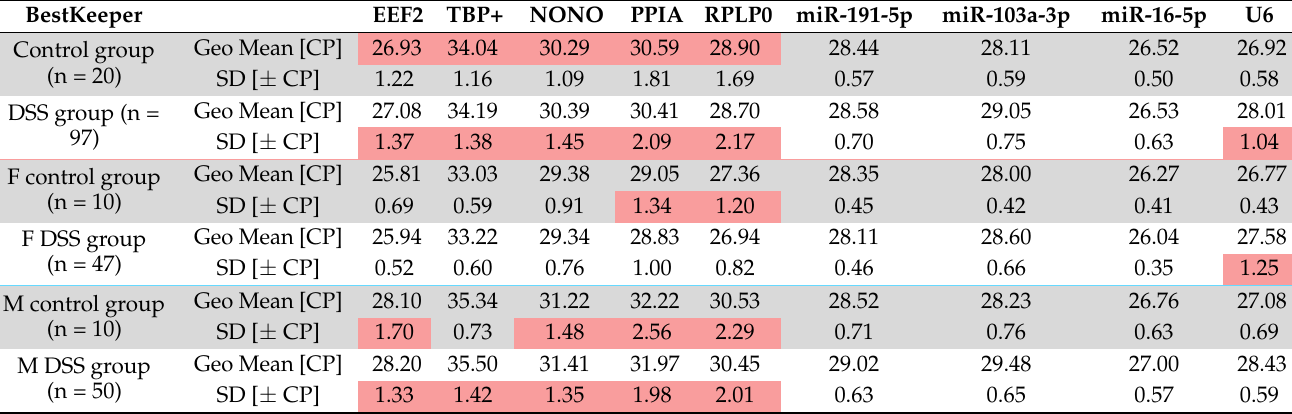
Table 4. Expression stability of candidate reference genes in archived FFPE colon samples of control and DSS-treated C57BL6/JOlaHsd mice, calculated with BestKeeper. Legend: F, female; M, male; CP, crossing point (BestKeeper’s notation for Cq); SD, standard deviation; grey cells denote control groups; white cells denote DSS groups; red cells denote low expression stability (high SD-values > 1); TBP+, number of samples (n) included in the calculation of TBP is smaller than shown in the first column (16 of 117 FFPE samples were undetermined for TBP, 2 from the control and 14 from DSS group, all undetermined FFPE samples were males).